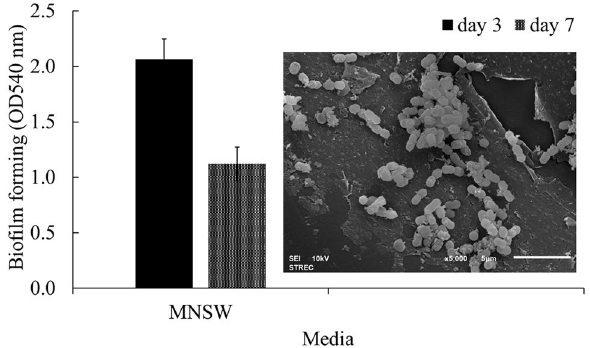
Figure 1. Crystal violet staining assay for testing biofilm formation by Exiguobacterium sp. AO-11 in MNSW medium incubated at room temperature for 3 and 7 days, and SEM micrographs of immobilized cells on bio- cord after 3 days of cultivation at room temperature with continuous shaking at 200 rpm. Data correspond to the means of triplicate values, and error bars correspond to the standard